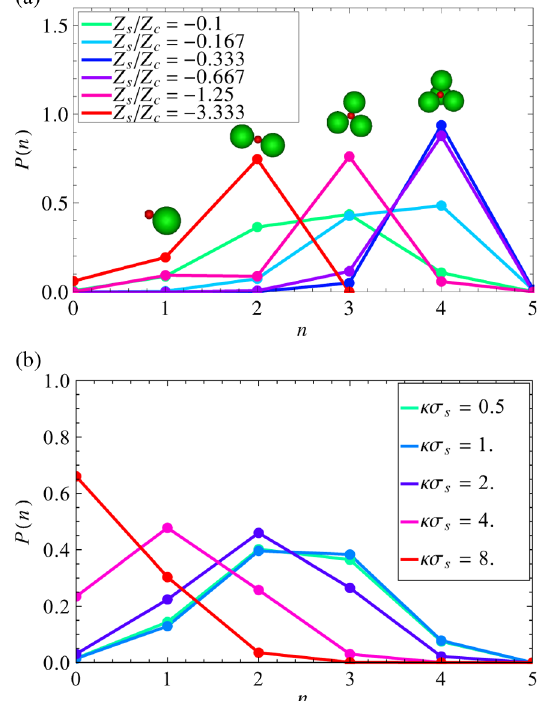
FIG. 6. Probability distributions of finding n satellite particles around a core particle, for size ratio σ s = σ c ¼ 3 = 1 . (a) Distribu- tions for different values of the charge ratio between satellite and core particles Z s =Z c , at a constant Debye screening length κσ ¼ 1 , where σ s s is the diameter of a satellite particle. (b) Dis- tributions for different values of the inverse Debye screening length κσ s , at a constant charge ratio Z s =Z c ¼ − 0 . 125 . Clusters that contain more than one core particle are not included in the calculation. In all cases, the charge of the core particles is kept constant, such that Z 2 c λ B = σ s ¼ 108 . 8 , the number ratio N =N ¼ 10 , and the total packing fraction η ¼ 0 . 10 . s c